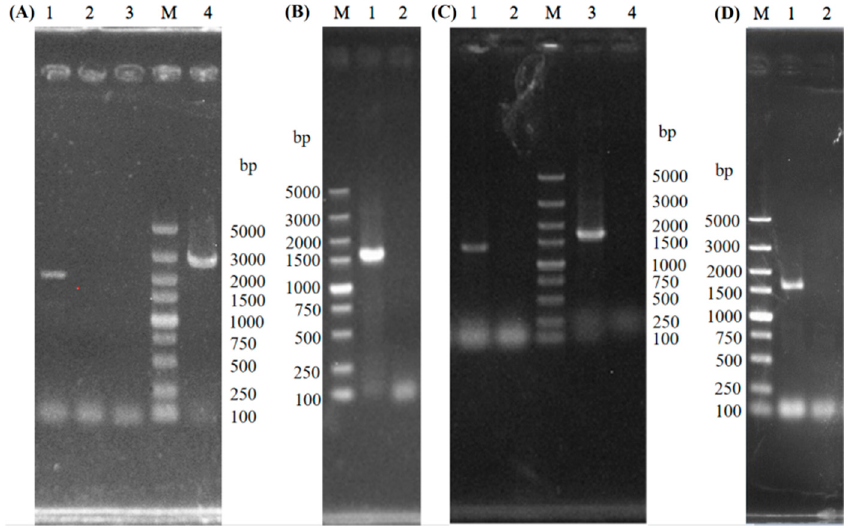
Figure 1. PCR verification of the recombinants . M: DL5000 DNA Marker; ( A ) lanes 1-2: PCR amplification results from SST1 and S-17 genome using the primers SST1-1-F and SST1-1-KanR; lanes 3–4: PCR amplification results from S-17 and SST1 genome using the primers SST1-2-KanF and SST1-2-R. ( B ) lanes 1–2: PCR amplification results from SST1 and SST1K genome using the primers K-U and K-D. ( C ) lanes 1-2: PCR amplification results from SDT1 and SST1K genome using the primers SDT1-1-F and SDT1-1-KanR; lanes 3–4: PCR amplification results from SDT1 and SST1K genome using the primers SDT1-2-KanF and SDT1-2-R. ( D ) lanes 1–2: PCR amplification results